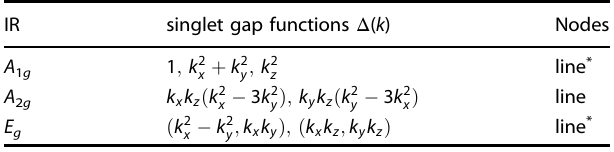
Table 1. Spin-singlet pairing states from irreducible representations of the point group D 3 d of Yb1